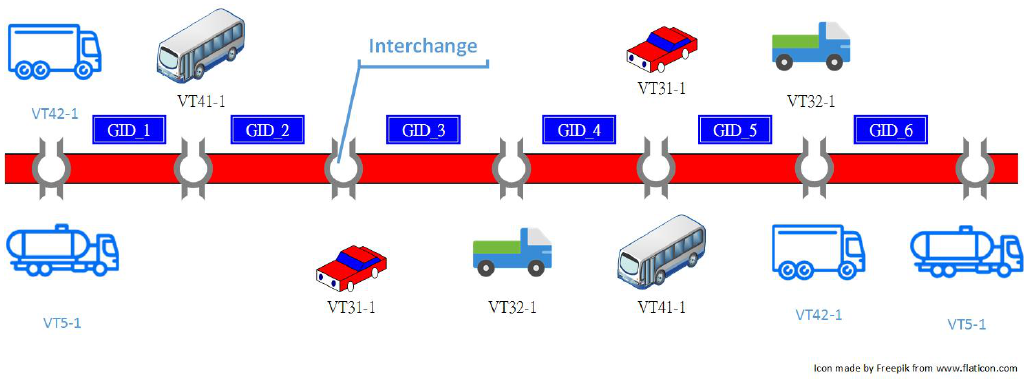
Figure 1. Example: five vehicles (VT) travel on a road and pass gantries with identifiers (GID); “Reproduced with permission from 2017 International Conference on Applied System Innovation (ICASI); published by IEEE,